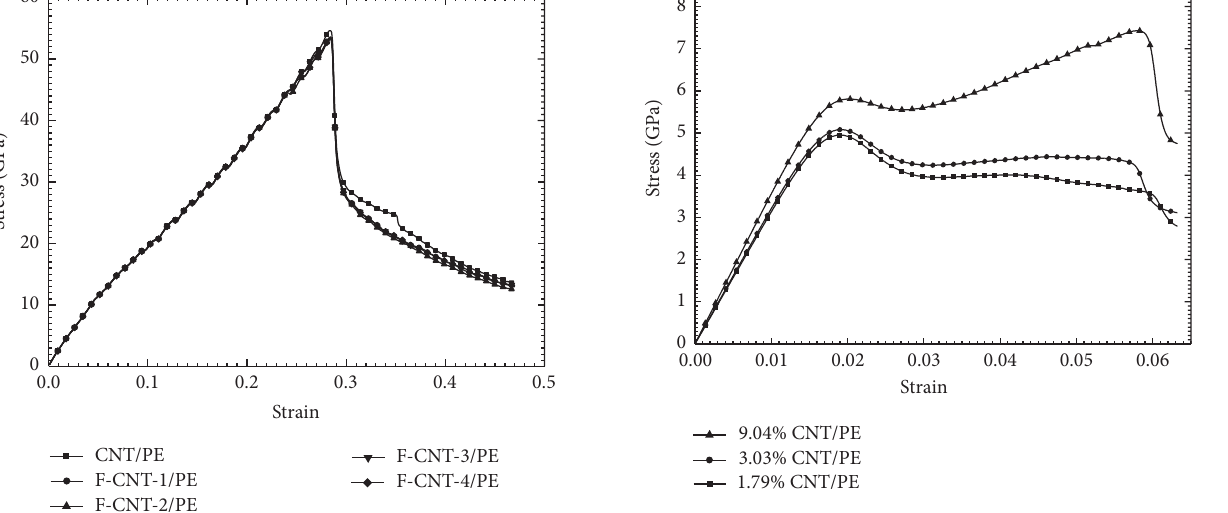
Figure 13: Variation of tensile stress versus strain of CNT/PE composites with different functionalization configurations.